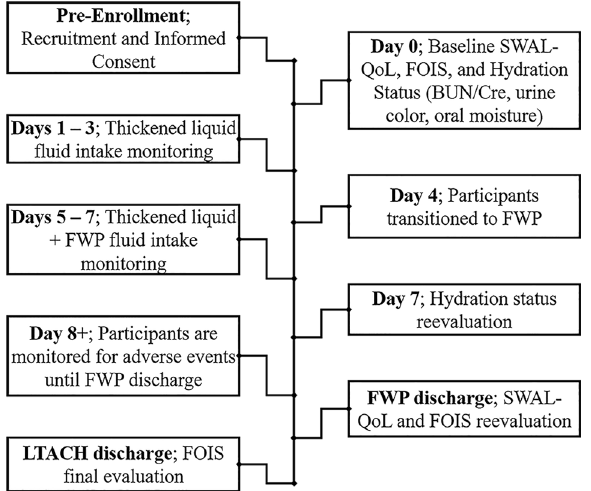
Figure 1. Treatment timeline. During Pre-Enrollment, inpatients identified with pharyngeal dysphagia were referred to study staff. Once recruited, baseline SWAL-QOL, FOIS, and hydration status (BUN/Cr, oral dryness, and urine color) were collected the day prior to starting the study (Day 0). During the baseline period (Days 1–3), participant fluid intake of orally delivered thickened liquids and any enteral delivered liquids were recorded. After the baseline period, participants were initiated on the FWP (Day 4). During the FWP period (Days 5–7), fluid intake of oral thickened liquids, enteral liquids, and oral thin liquid water were